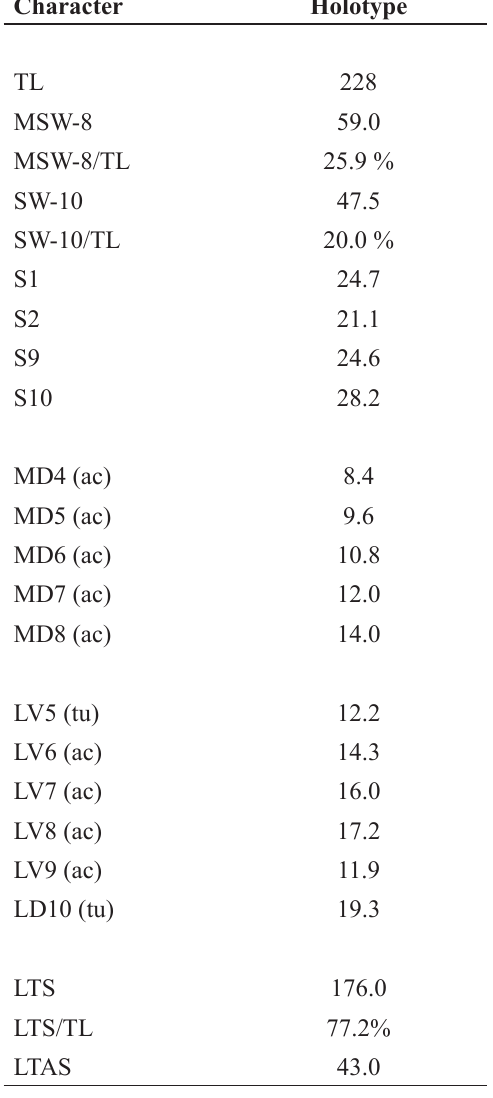
Table 5. Measurements extracted from Zelinka (1913) of female holotype of Echinoderes ehlersi Zelinka, 1913 from Zanzibar, Tanzania (in